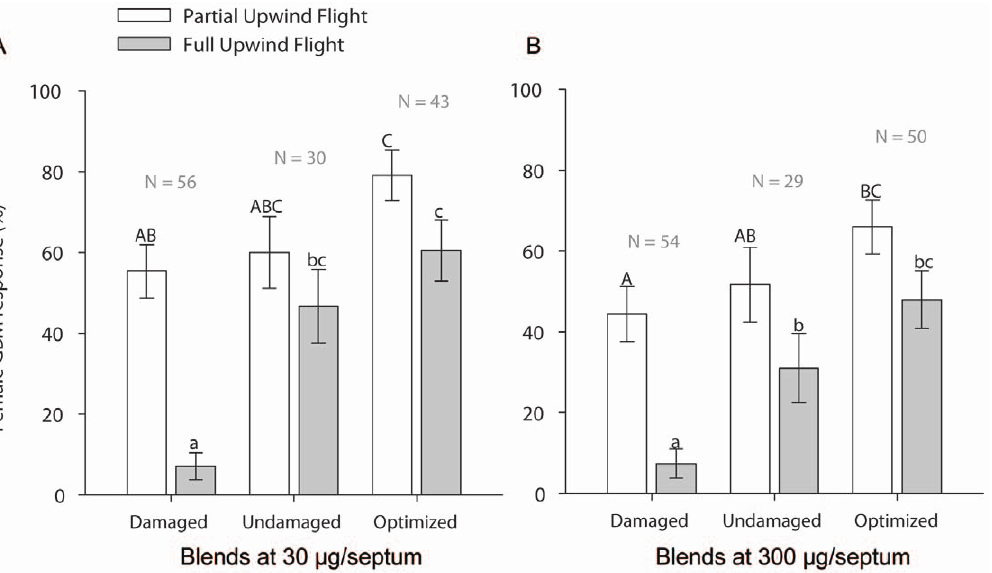
Figure 4. Response of female P.viteana to modulations in ratio and concentration. Partial and full upwind flight responses (% 6 1 SE ) of female P. viteana ( N =262) to three different synthetic blends (optimized blend vs. Japanese beetle undamaged blend vs. Japanese beetle damaged blend in Table 1) at two doses, (A) containing 30 m g of the 7 compounds per lure and (B) containing 300 m g of the 7 compounds per lure. Partial upwind flight was recorded when P. viteana made more than 50 cm of zig-zag upwind flight toward the target. Full upwind flight was the upwind flight to within 10 cm of the target. Different letters (capital letters for partial upwind flight response and small letters for full upwind flight response) on bars indicate significant differences ( P , 0.05).